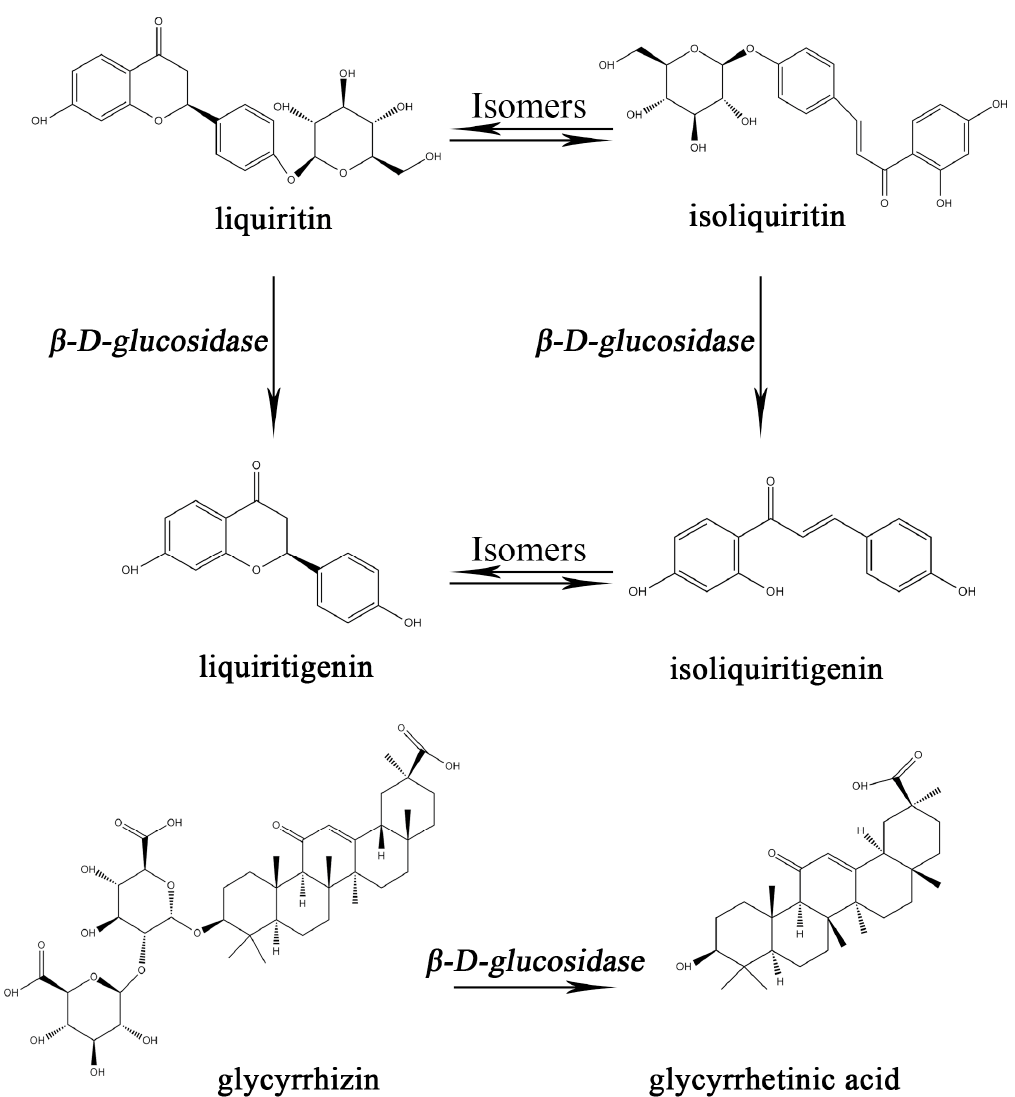
Figure 1. The chemical structures of six components in Gancao and the relationship of between them are annotated in the figure as appropriate.